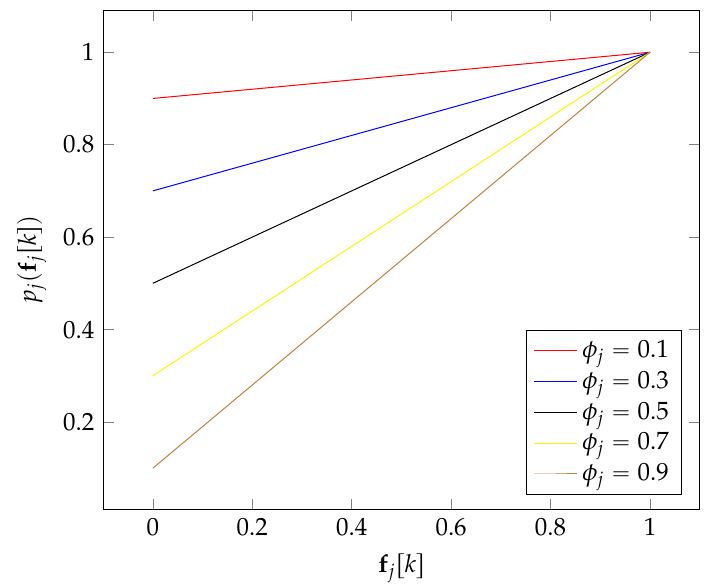
Figure 2. Graphs of boosting function p j for different φ j